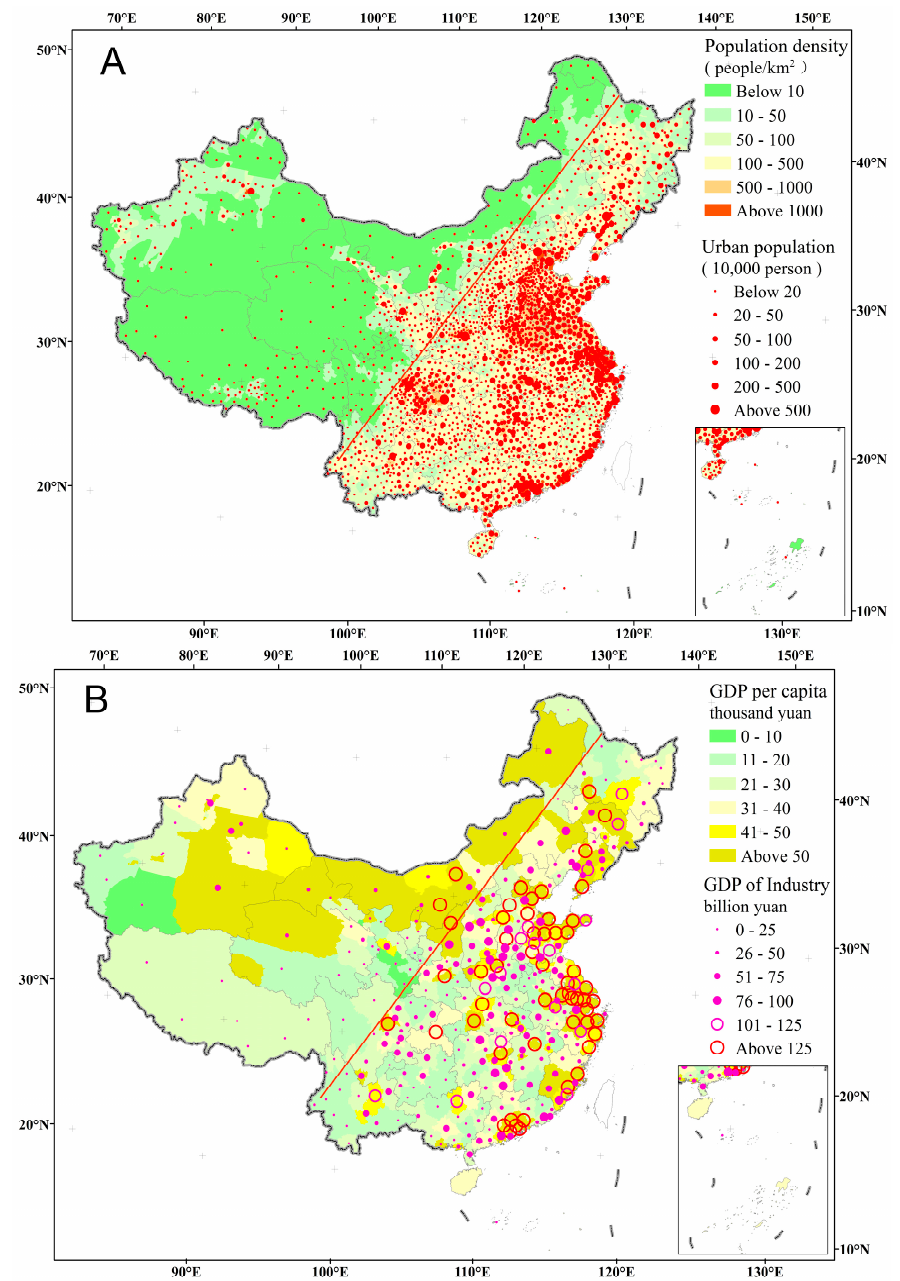
Figure 3. The spatial pattern of population density ( A ); and the spatial pattern of GDP per capita and GDP of industry ( B ). All documents are extracted from the China Statistical Year Book for Regional Economy (2014) [9].